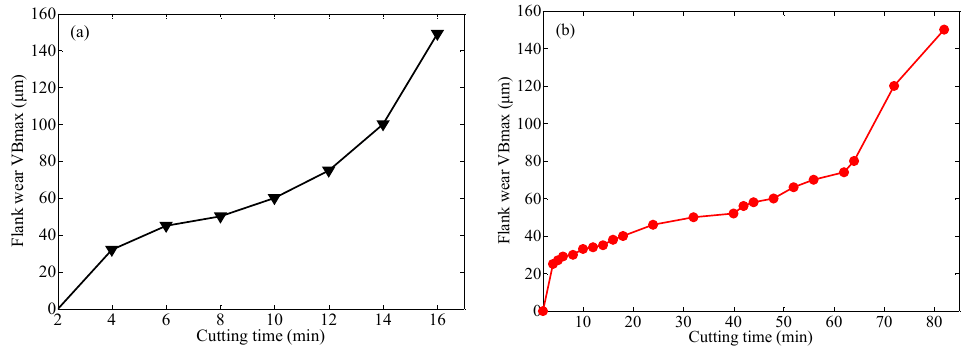
Figure 6. ( a ) The flank face wear curve of the Tool A. ( b ) The flank face wear curve of the Tool B.